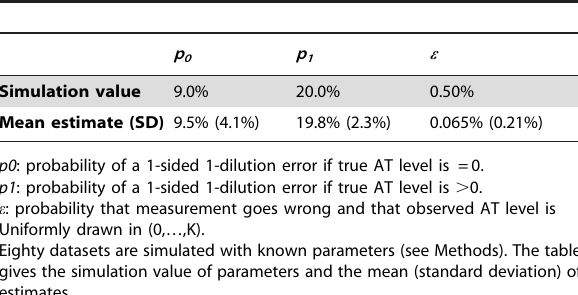
Table 1. Performance of the method to estimate parameters characterizing measurement